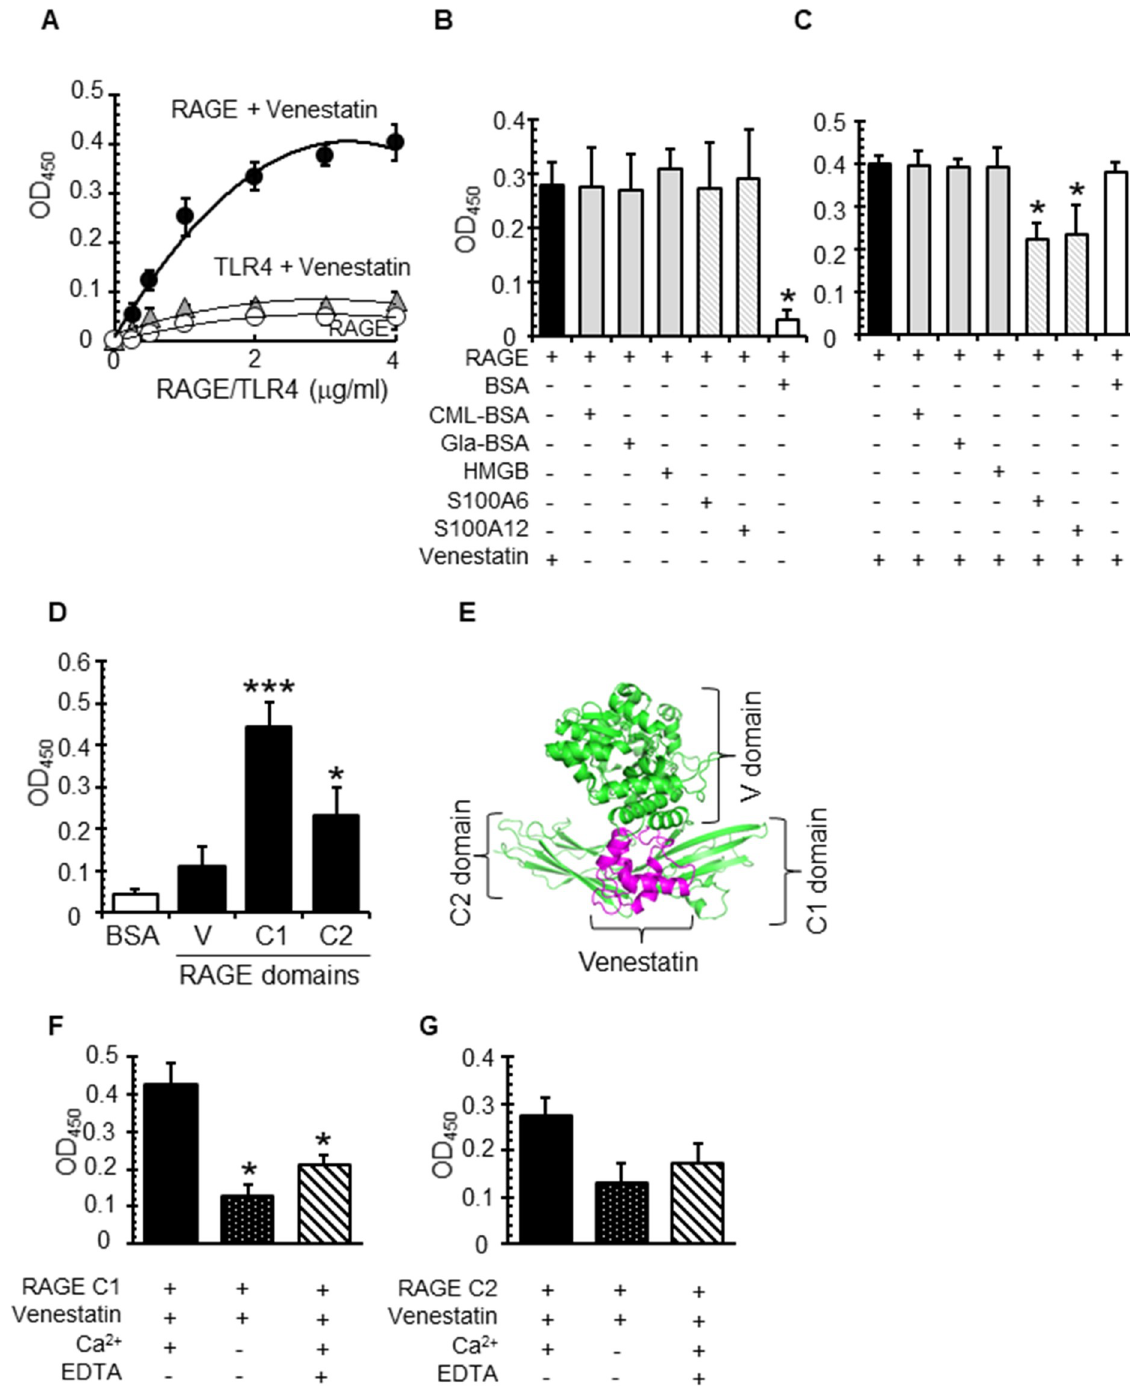
Fig 1. Venestatin bound to RAGE. (A) Venestatin bound to RAGE, but not TLR4, in a concentration-dependent manner. Venestatin-coated (4 μ g/mL) wells were reacted with RAGE/TLR4 (0–4 μ g/mL) and treated with anti-RAGE or anti-TLR4 antibodies. BSA-coated negative control wells were reacted with RAGE (white circles). Antibodies were detected using HRP-conjugated IgG. (B) Venestatin and other established RAGE ligands bound to RAGE. Venestatin, other RAGE ligands, or BSA (4 μ g/mL) were used to coat wells and then reacted with RAGE (1 μ g/mL). � p < 0.01 from the venestatin-RAGE binding group. (C) Competitive binding of venestatin to the C1 and C2 domains of RAGE. RAGE (4 μ g/mL) was used to coat wells, and wells were then treated with venestatin alone (8 μ g/mL) or a mixture of venestatin plus other RAGE ligands (4 μ g/mL). Bound venestatin was detected with anti-venestatin sera. � p < 0.01 from a venestatin-RAGE binding group. (D) Venestatin bound to the C1 and C2 domains of RAGE. Wells were coated with V, C1, and C2 domains (4 μ g/mL) and then reacted with